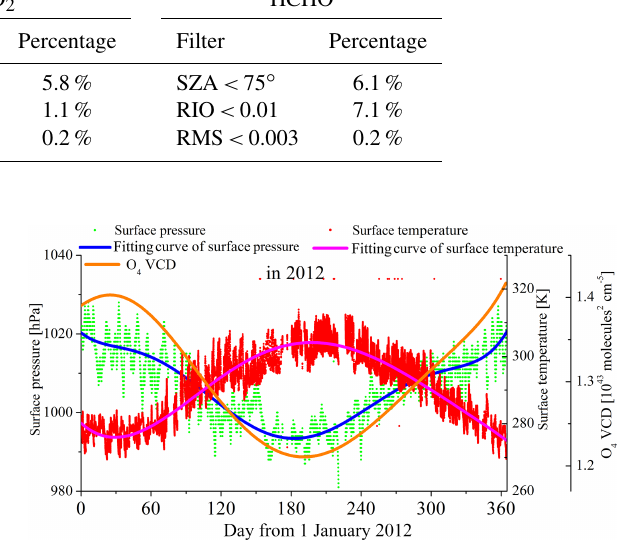
Figure 3. Annual variation of surface temperature and surface pres- sure as well as fitted 6th-order polynomials in 2012. Also shown are the O 4 VCDs calculated based on the fitted curves of the mea- sured annual variations of surface temperature and pressure in 2012 (similar results are found for other